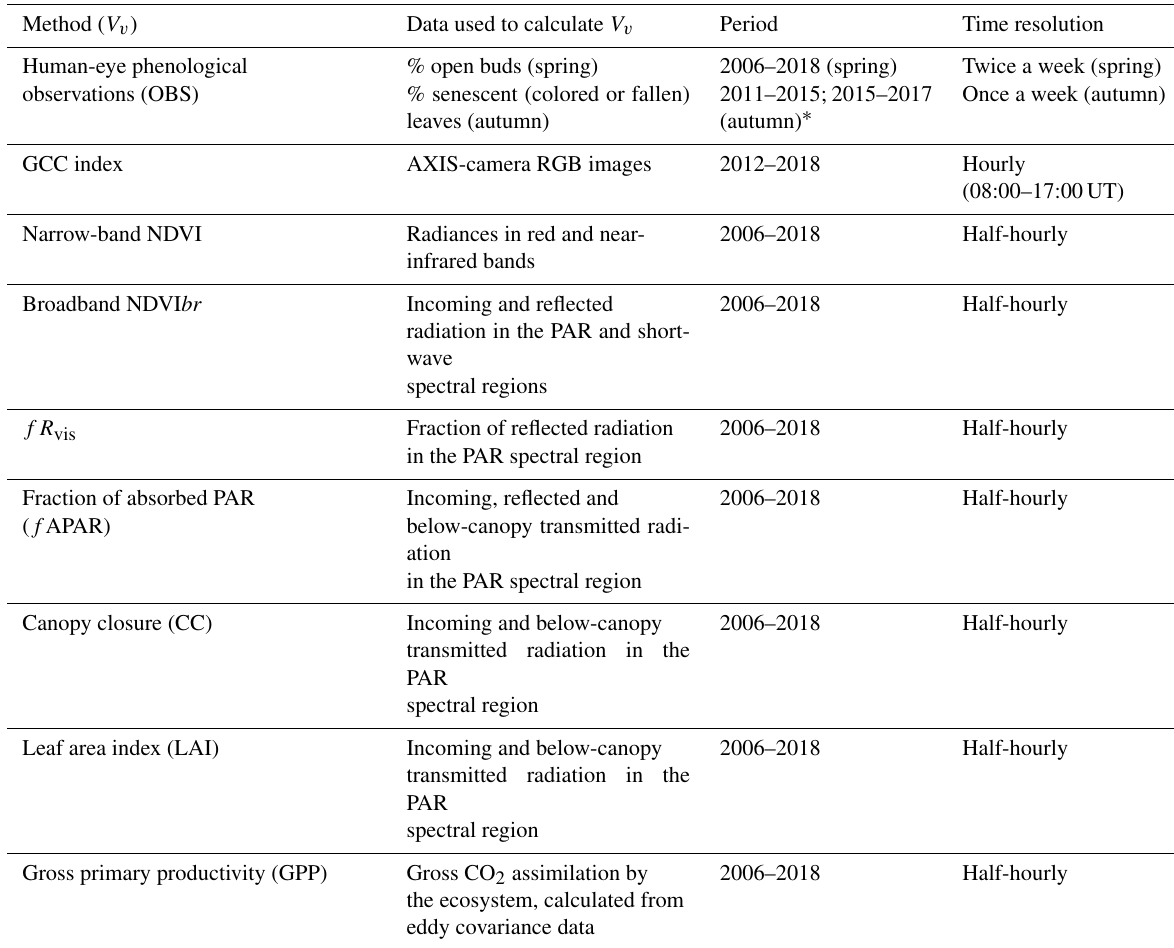
Table 1. Methods and variables used in the calculation of phenology metrics in the Fontainebleau–Barbeau forest. NDVI: narrow-band Normalized Difference Vegetation Index; NDVI br : broadband NDVI; f R vis : fraction of reflected radiation by the canopy in the PAR spectral domain; GCC: greenness chromatic coordinate from RGB camera images; f APAR: fraction of absorbed radiation in the PAR